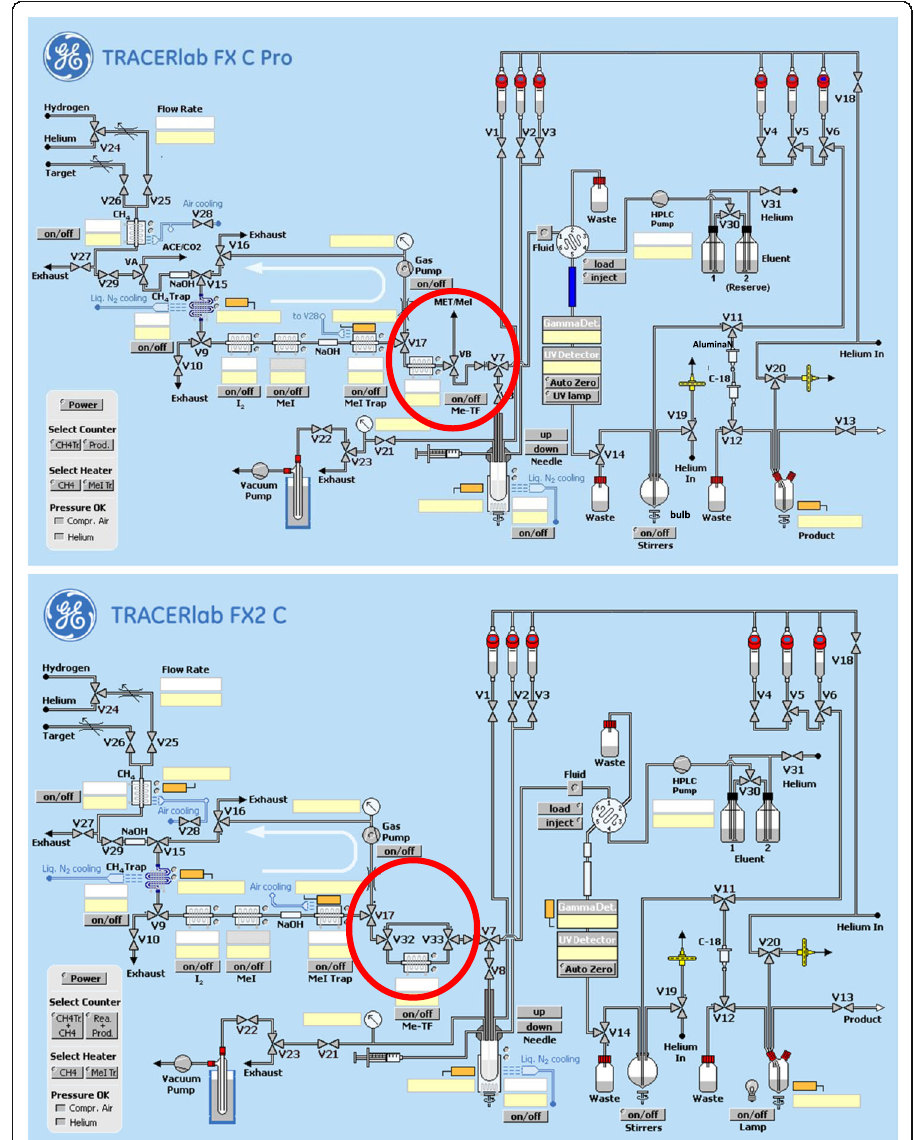
Fig. 2 Flow charts of the used synthesis modules TRACERlab ™ FX C Pro and TRACERlab ™ FX2 C. The major differences between the set-ups concern the installation of the silver triflate column are highlighted (red